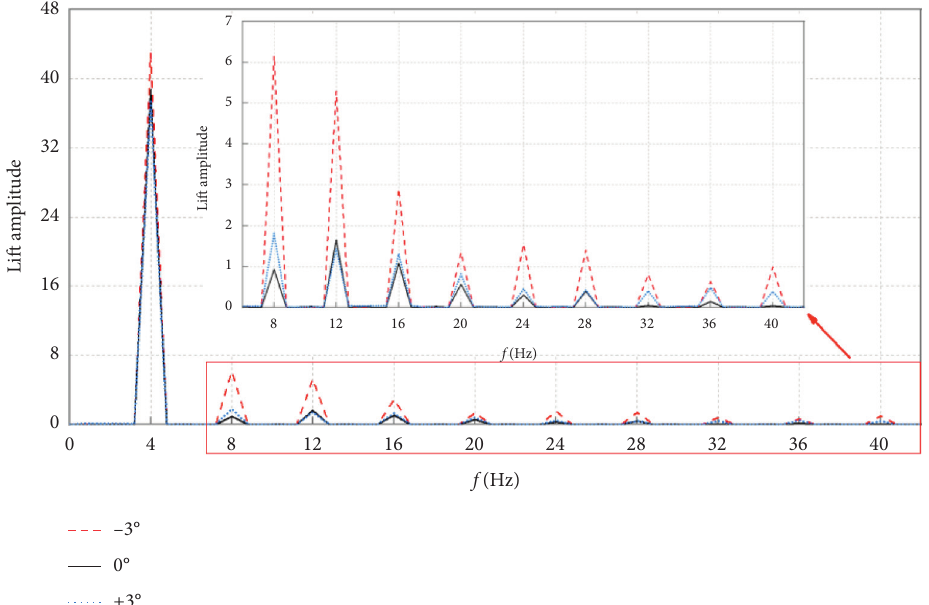
Figure 17: Aerodynamic lift spectrum under single frequency heaving motion of large